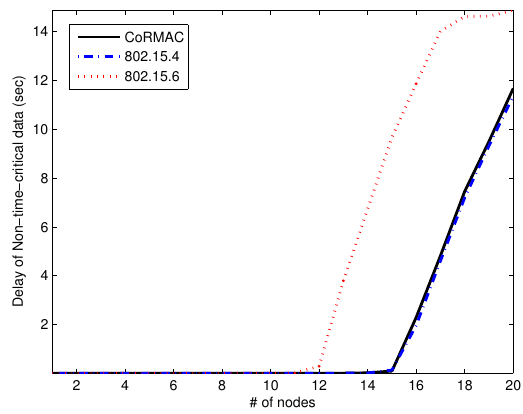
Figure 6. The average delay of non-time-critical data vs. the number of nodes.